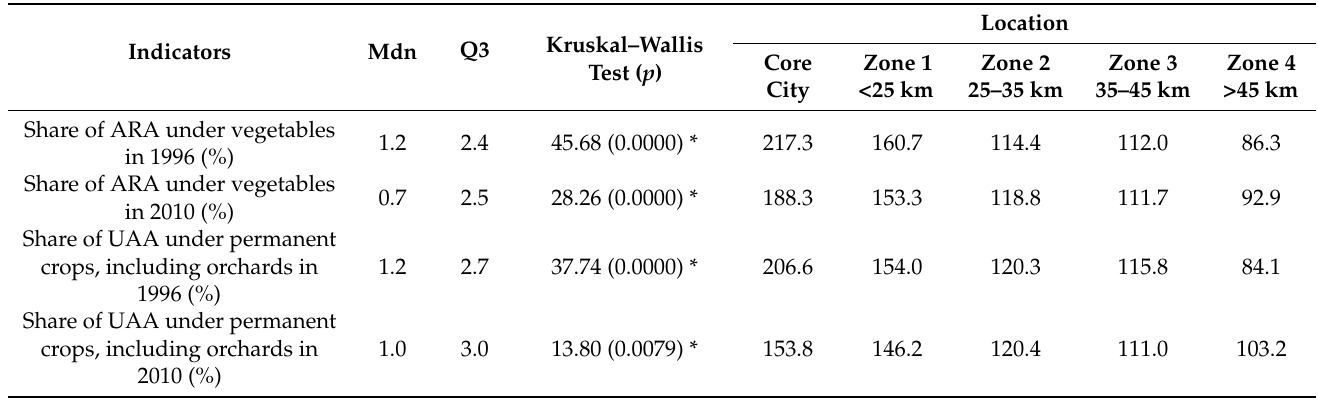
Table 8. Median, quartile, and median rank size of selected variables building factor F4, depending on the